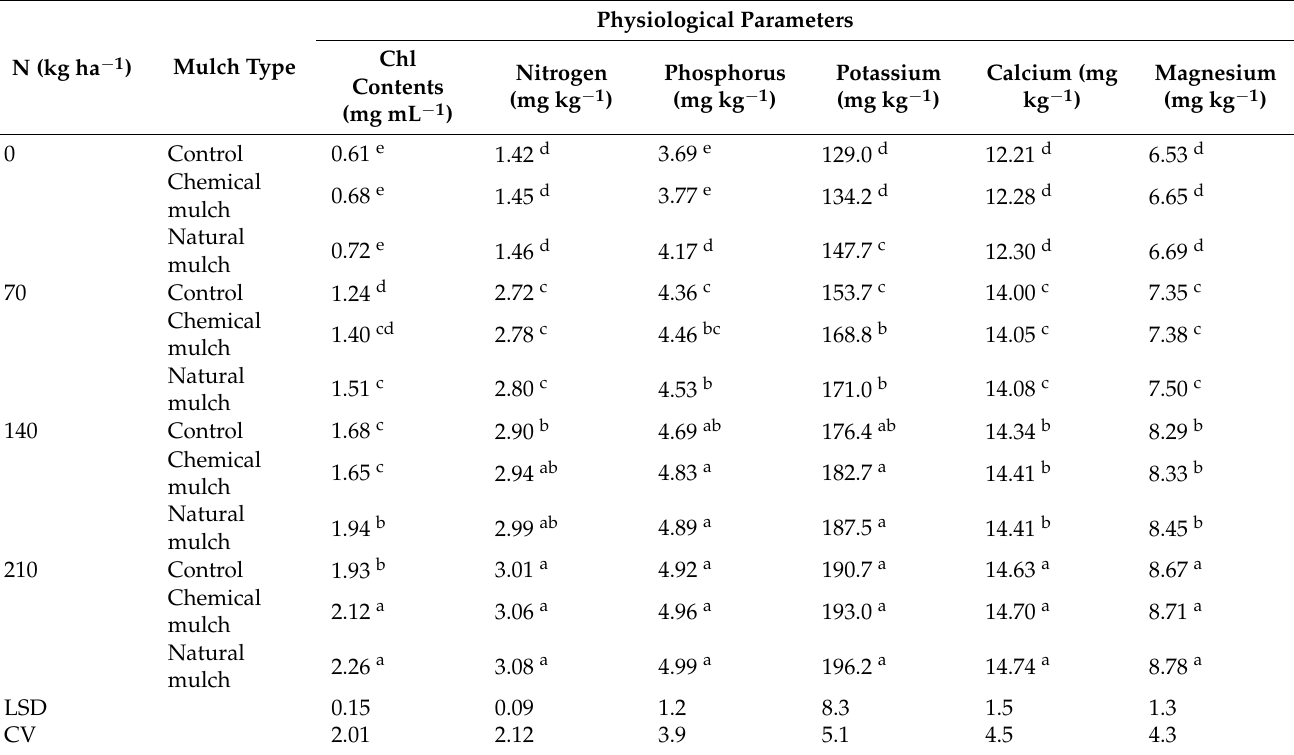
Table 1. Effects of nitrogen (N) fertilization and mulches on physiological parameters in cotton during